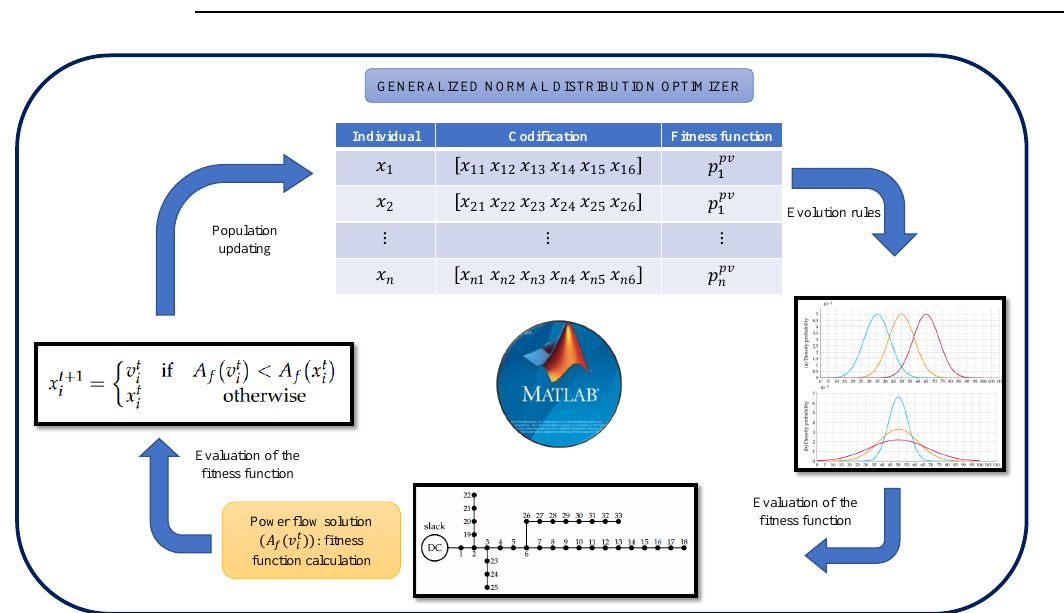
Figure 2. General implementation of the GNDO approach in MATLAB software for the studied